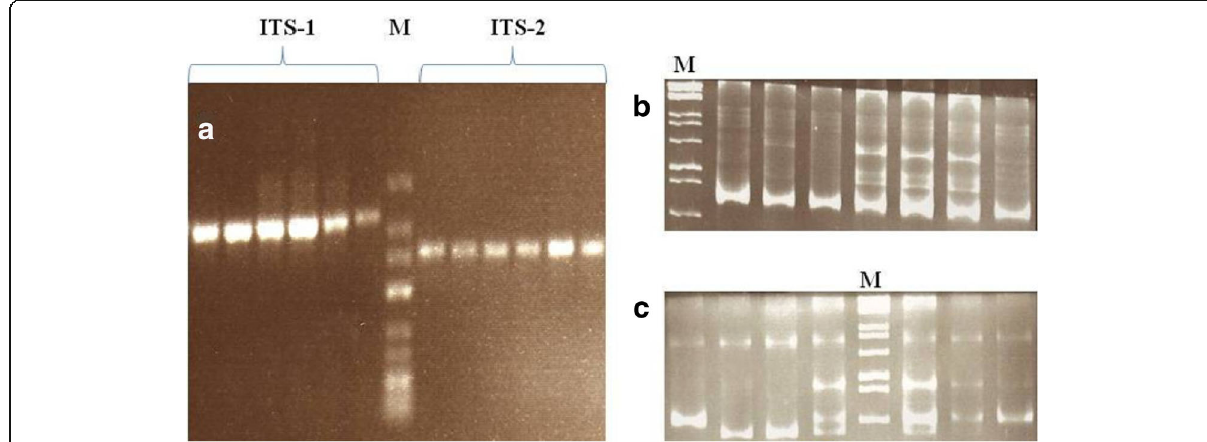
Fig. 5 Ethidium bromide-stained gel analysis of gDNA of Contracaecum L3 types. a Image of PCR products of ITS-1 and ITS-2 sequences of Con- tracaecum larvae in an 1.5% agarose gel under UV light. b SSCP patterns of ITS-1 sequences of Contracaecum larvae. c SSCP patterns of ITS-2 se- quences of Contracaecum larvae. M: DNA